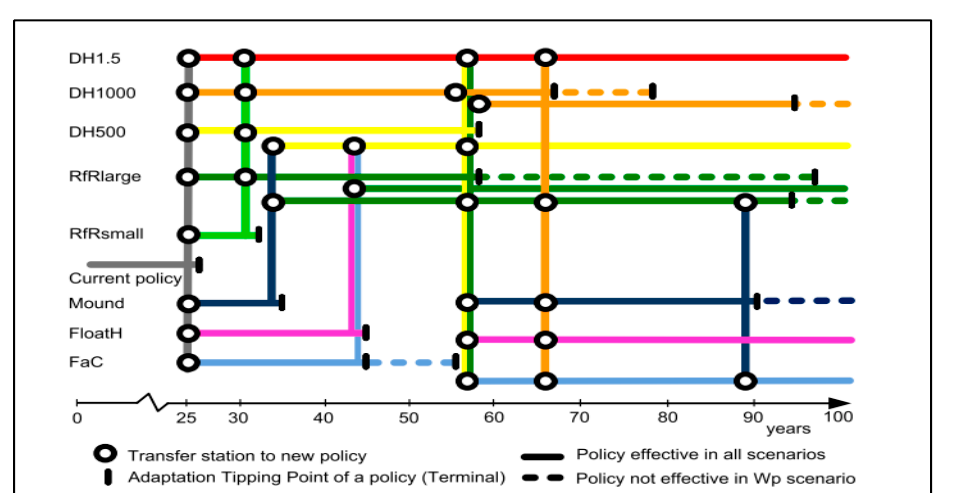
Figure 5. Adaptation pathway map for flood management based on the median value for the sell-by date of policy options for all climate realizations for the Waas Case adapted from [14].